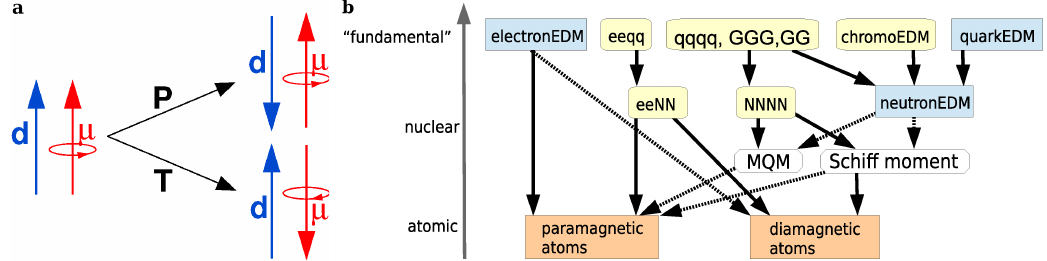
Figure 1. ( a ) a non-zero electric dipole moment (EDM) d aligned with the magnetic moment µ violates both parity (P) and time-reversal (T) symmetry. Hence, assuming CPT —with C refering to charge-conjugation—to be conserved, d (cid:54) = 0 also violates CP symmetry; ( b ) CP violating sources contributing to EDMs in various systems on different energy scales. Fundamental particle EDMs (blue boxes) as wells as CP -odd interactions (yellow boxes) between electrons (e), quarks (q) and gluons (G) lead to EDMs of complex systems like atoms (orange boxes). Nuclear moments (white boxes) of atoms, e.g., magnetic quadrupole moments (MQM) and Schiff moments [5], arise from CP -odd